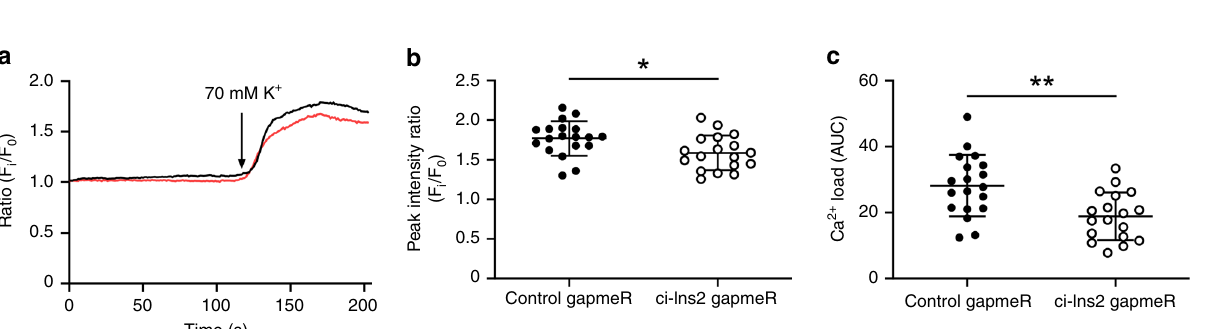
Fig. 7 ci-Ins2 knockdown decreases depolarization-induced Ca 2 + in fl ux. a – c Rat islets were transfected with control (black circles) or ci-Ins2 (clear circles) gapmeRs and dissociated into single cells. Experiments were performed 48 h after transfection. a Representative Ca 2 + imaging in control (black line) or ci-Ins2 (red line) gapmeRs. b Ca 2 + peak intensity and c integrated Ca 2 + load after K + stimulation. n = 18 (ci-Ins2 gapmeR) and 19 (control gapmeR) cells from two independent experiments. Data and mean are represented ± s.d. * p = 0.015 and ** p = 0.002 by two-tailed unpaired t -test. Source data are provided as a Source Data fi le.